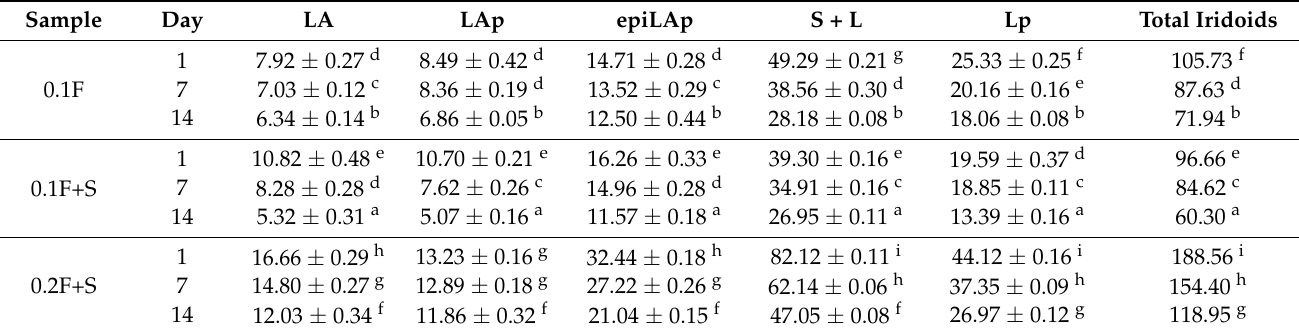
Table 9. Changes of iridoids contents (mg/L) in yoghurt samples during